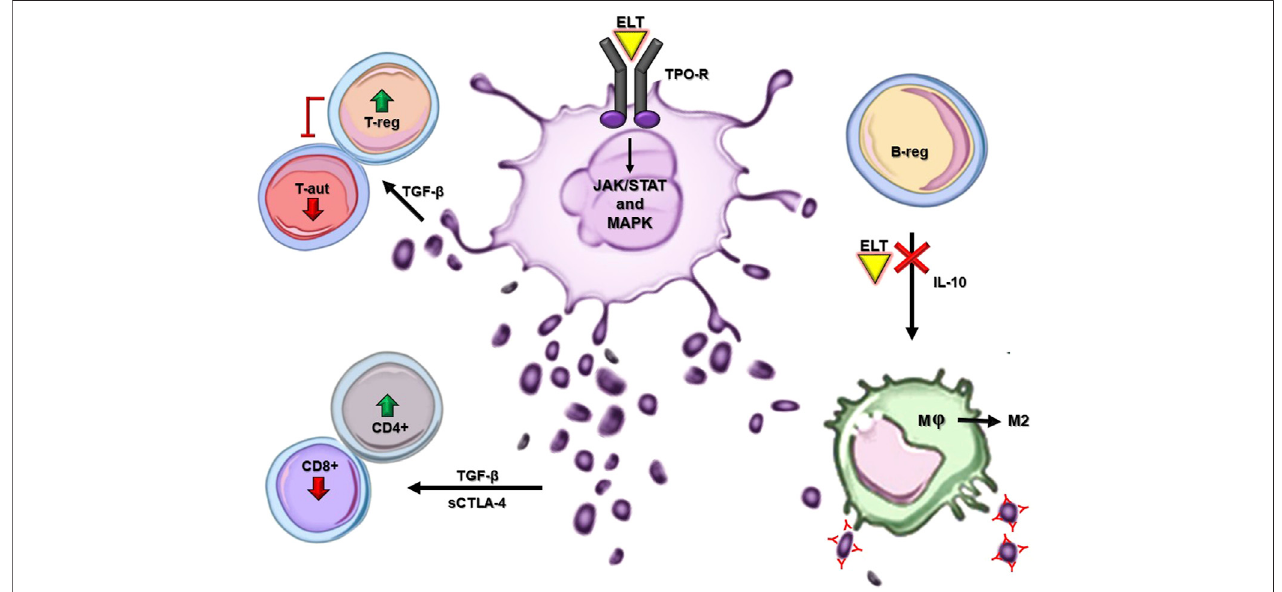
FIGURE1| ELTmechanismofactionand mainoff-targeteffects inITP.Majorcellularand molecular pathways exerttheimmunomodulatoryandanti-in fl ammatory effects of ELT in ITP. In-silico models are not reported in this fi gure. ELT: eltrombopag, TPO-R: thrombopoietin receptor, T-reg: T regulatory lymphocyte, T-aut: T autoreactive lymphocyte, B-reg: B regulatory lymphocyte, CD4+: T helper lymphocyte, Cd8+: T cytotoxic lymphocyte, M: macrophage, M2: anti-in fl ammatory